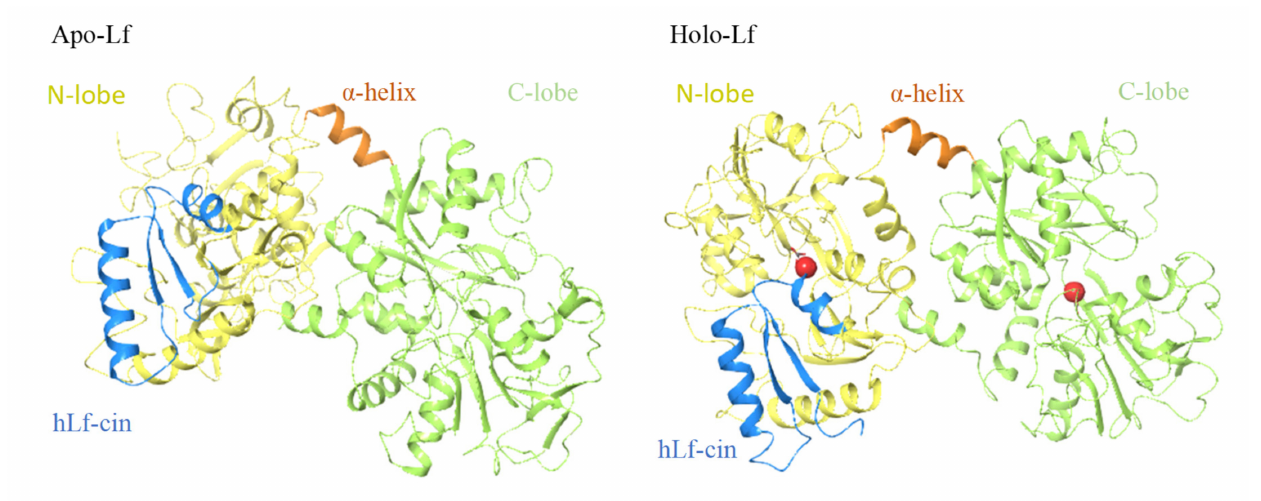
Figure 1. Structure of human apo-lactoferrin ( left ) and holo-lactoferrin ( right ). Yellow, N-lobes (amino acids 1–333); green, C-lobes (amino acids 345–691); orange, short joining α -helix (amino acids 334–344); blue, human lactoferricin cleavage peptide (amino acids